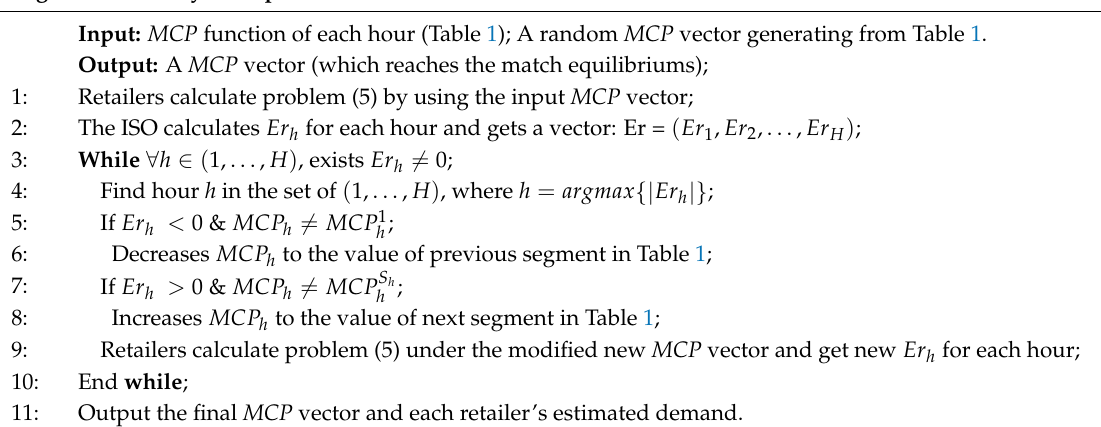
Algorithm 2 Analytical optimization